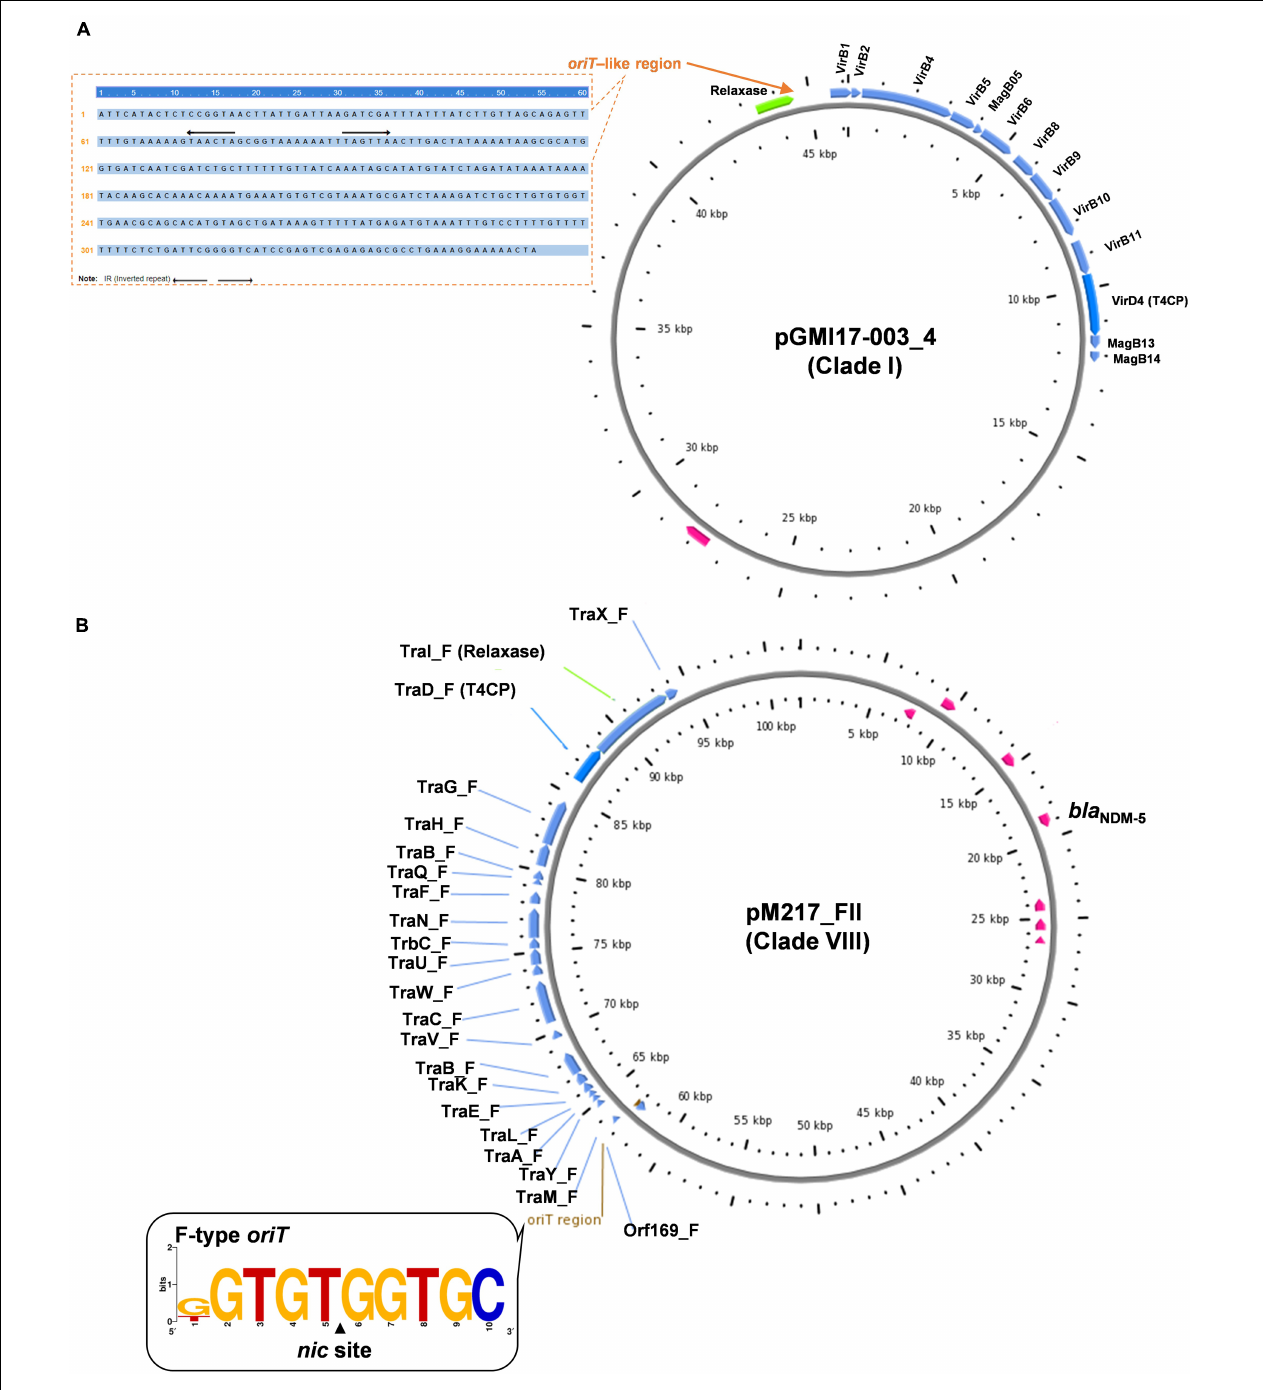
FIGURE 3 | Conjugative transfer modules including oriT , relaxase, T4CP, and T4SS of the representative plasmids from Clade I (A) and Clade VIII (B) , respectively.